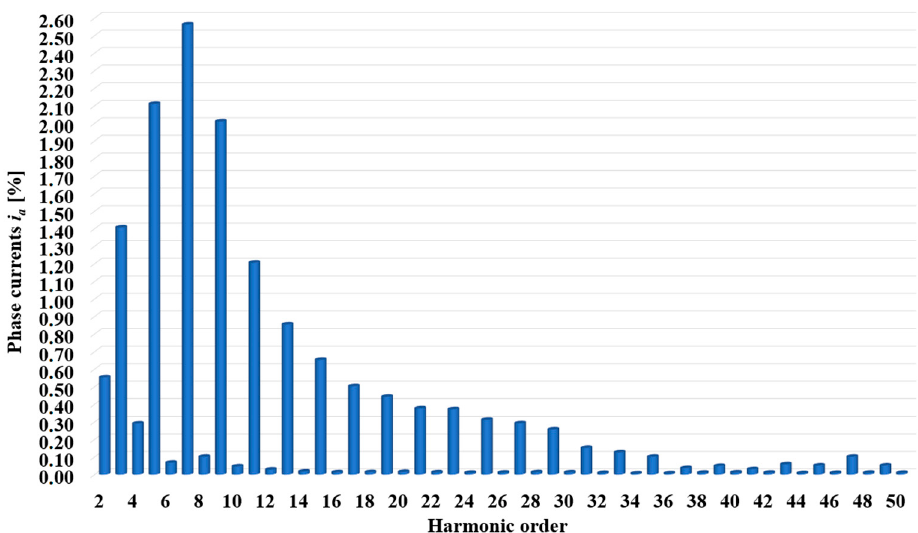
Figure 16. Grid side converter waveforms: leg-to-neutral switching voltage u a1(sw) before the output power filter (yellow track), fundamental component (green track), injected phase current (magenta track).